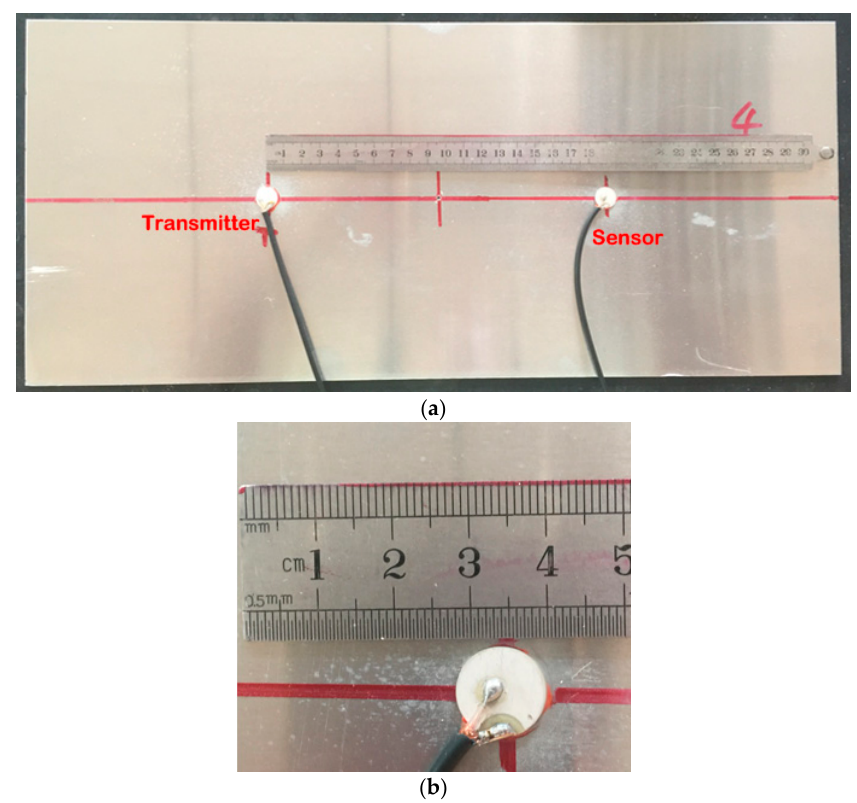
Figure 4. An aluminum plate with PZT (lead zirconate titanate) disks: ( a ) an aluminum plate (Alloy 5052) with a PZT transmitter and a PZT sensor; ( b ) a PZT on the aluminum plate.